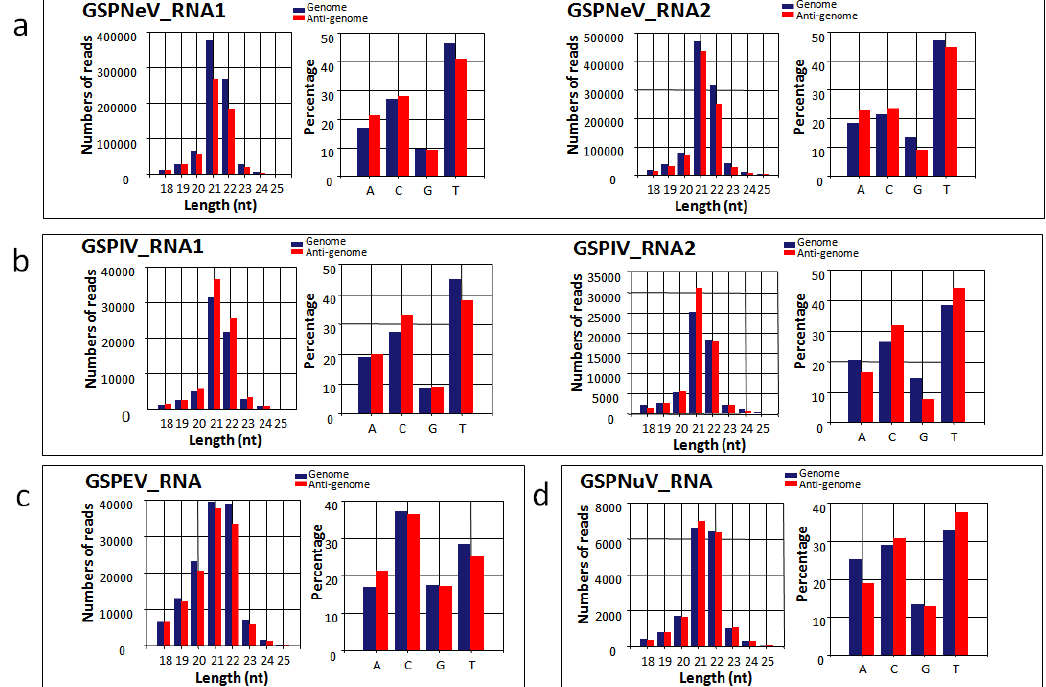
Figure 7. The vsiRNA size distribution, and 5 (cid:48) end nucleotide preference of GSPNeV ( a ), GSPIV ( b ), GSPEV ( c ), and GSPNuV ( d ).